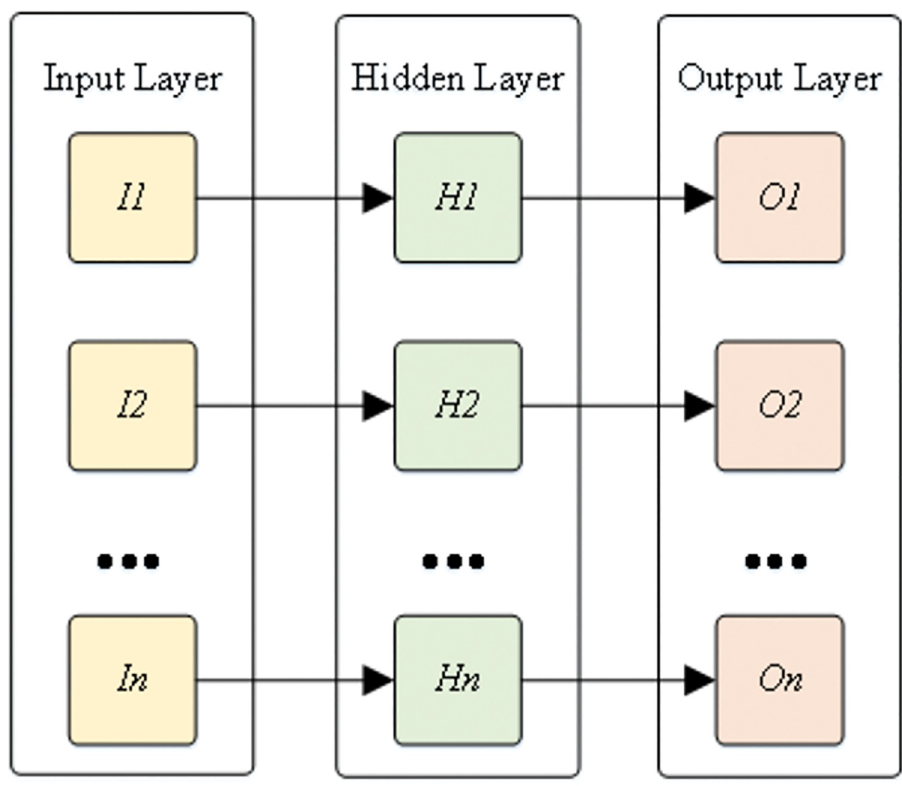
Fig 3. Neural network structure.